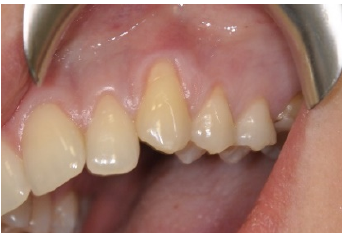
Figure 2. Multiple adjacent gingival recessions in control group patient before the surgical procedure.